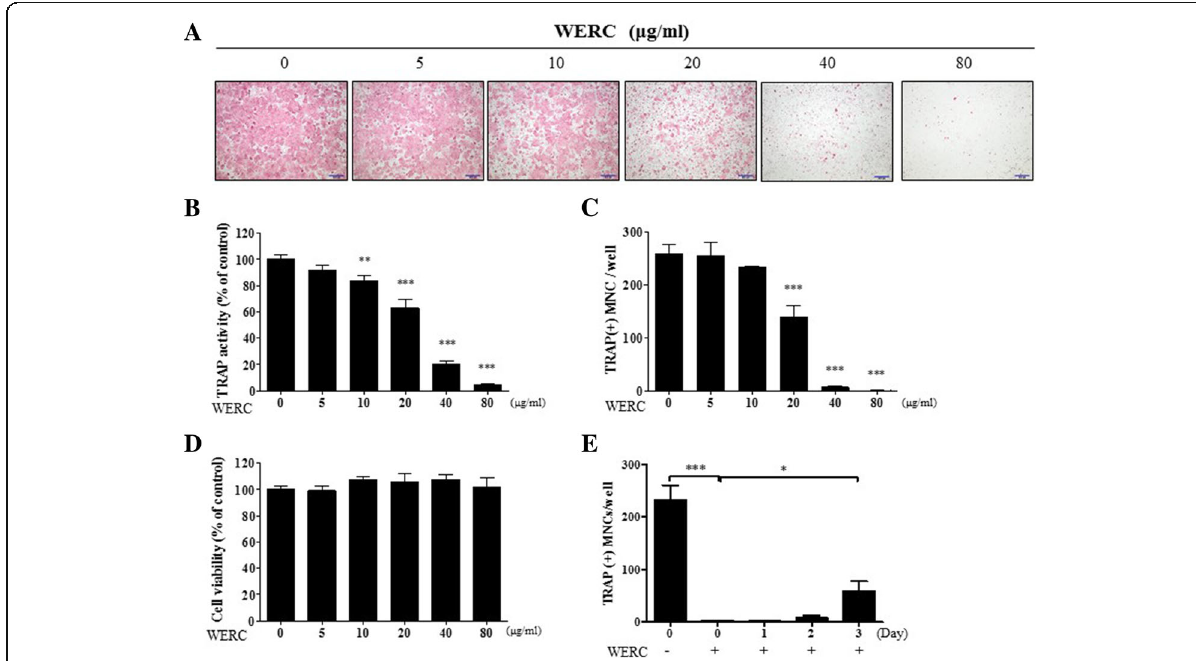
Fig. 4 WERC suppresses osteoclast differentiation. BMMs were cultured in differentiation medium (DM) containing M-CSF and RANKL for 4 days with vehicle or WERC (10, 20, 40, 80, and 160 μ g/mL). The cells cultured in DM were stained for ( a ) TRAP staining and were determined by the ( b ) TRAP activity assay on day 4 (100 × magnification). ( c ) TRAP-positive MNCs were counted on day 4. ( d ) The cells were cultured with WERC and M-CSF to examine cell viability on day 2. ( e ) The cells were cultured in DM in between additions of WERC (80 μ g/mL) at the indicated days, and the osteoclast numbers were counted on day 4. * p < 0.05, ** p < 0.01, *** p <